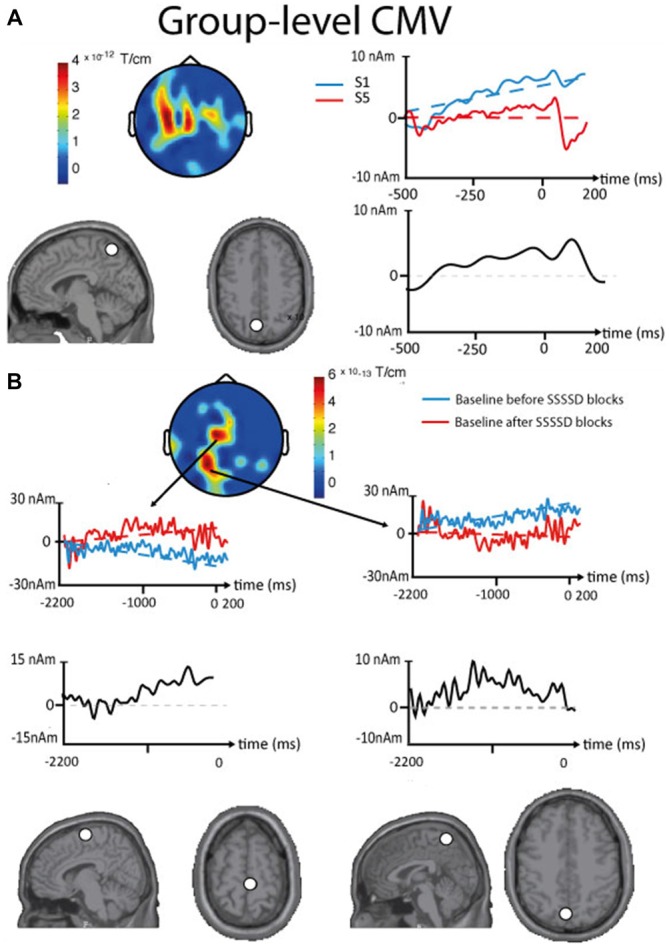
Results of the contingent magnetic variation (CMV) baseline drift obtained in the sensor and the source spaces at the group level. (A) Intra-block CMV. Top, left. Topographic plot (sensors array viewed from the top, Euclidian norm of orthogonal planar gradiometers) locating the significant differences in baseline drift between the first (S1) and the fifth stimuli (S5) of standard SSSSD blocks. Top, right. Time courses from one significant sensor with their linear fit (dotted lines). Bottom, left. Axial and sagittal slices presented in the neurological convention showing the location of the ECD (white dot) that best explains the intra-block CMV. Bottom, right. Source waveform corresponding to the intra-block CMV. (B) Inter-block CMV. Top, Middle. Topographic plot (sensors array viewed from the top, Euclidian norm of orthogonal planar gradiometers) locating the significant differences in baseline drift between the standard SSSSD blocks occurring before and after deviant SSSSS blocks. Left and Right. Time courses from significant sensors with their linear fit (dotted lines). Middle. Source waveforms corresponding to the intra-block CMV. Bottom. Axial and sagittal slices presented in the neurological convention showing the locations of the ECDs (white dot) that best explain the inter-block CMV baseline drift (Left, SMA; Right, PPC).